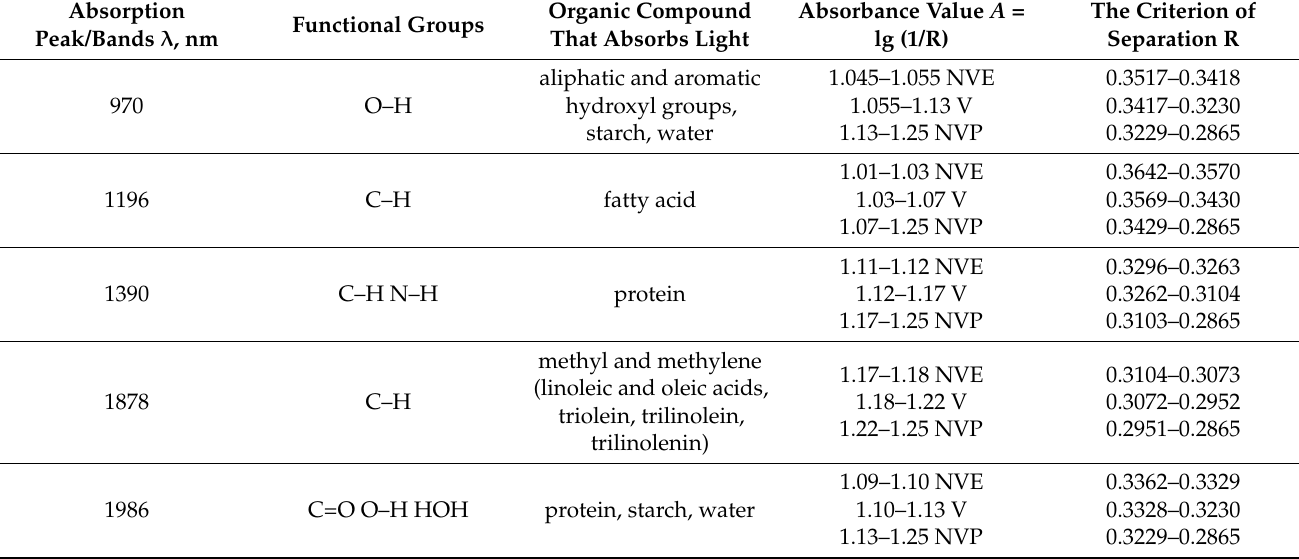
Table 1. Options for selecting a single seed detection criterion based on spectrometric parameters (adapted from [6,15,24,33,34]). Here, V—full viable; NVP—non-viable petrified; NVE—non-viable empty; O–H—hydroxyl group; C=O—carbonyl group; N–H—amine group; HOH—water; C–H—hydrocarbon